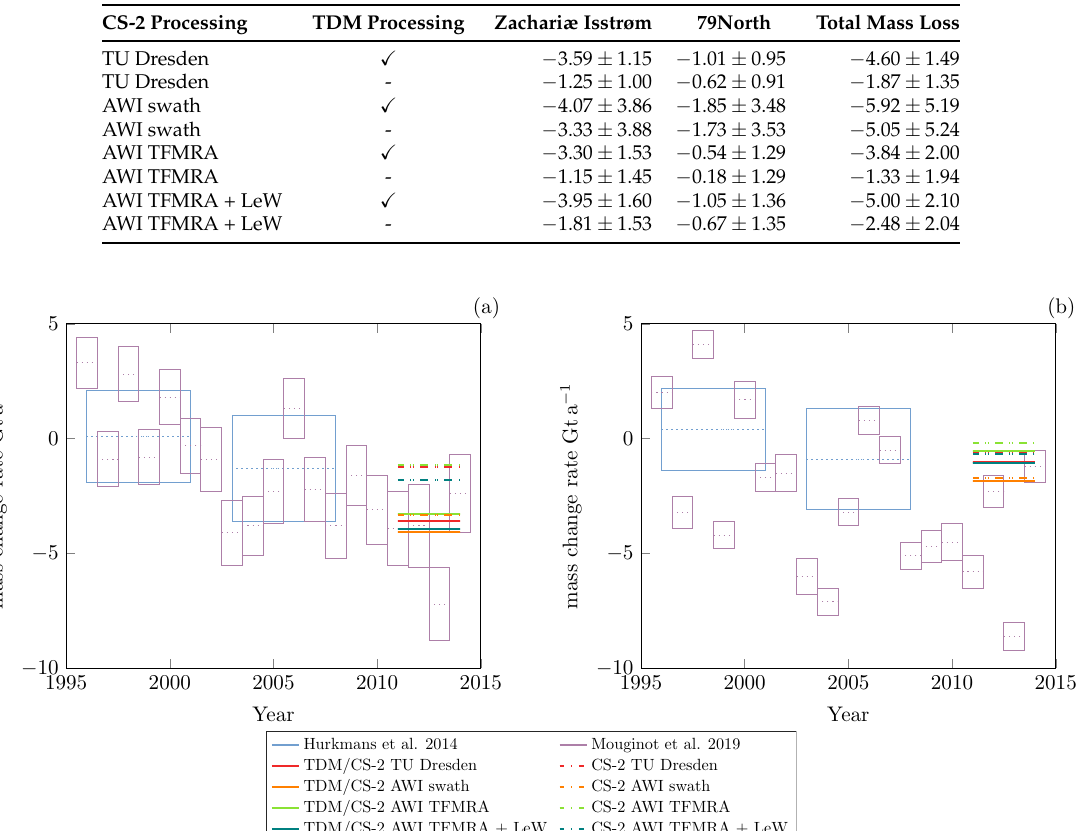
Table 6. dM estimates for Zachariæ Isstrøm and 79North in the time period between 01/01/2011 and dt 31/12/2013 for different CS-2 processing strategies. Units are Gta − 1 .